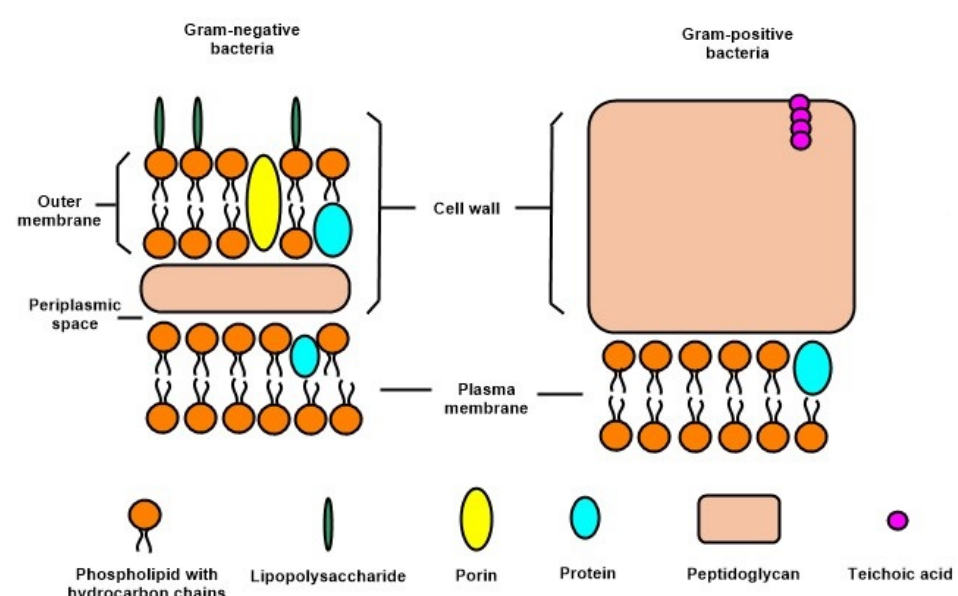
Figure 3. Structure difference of Gram-negative and -positive bacteria. Reproduced with modification from Slavin et al., Journal of Nanobiotechnology ; published by Spring Nature, 2017. [15].